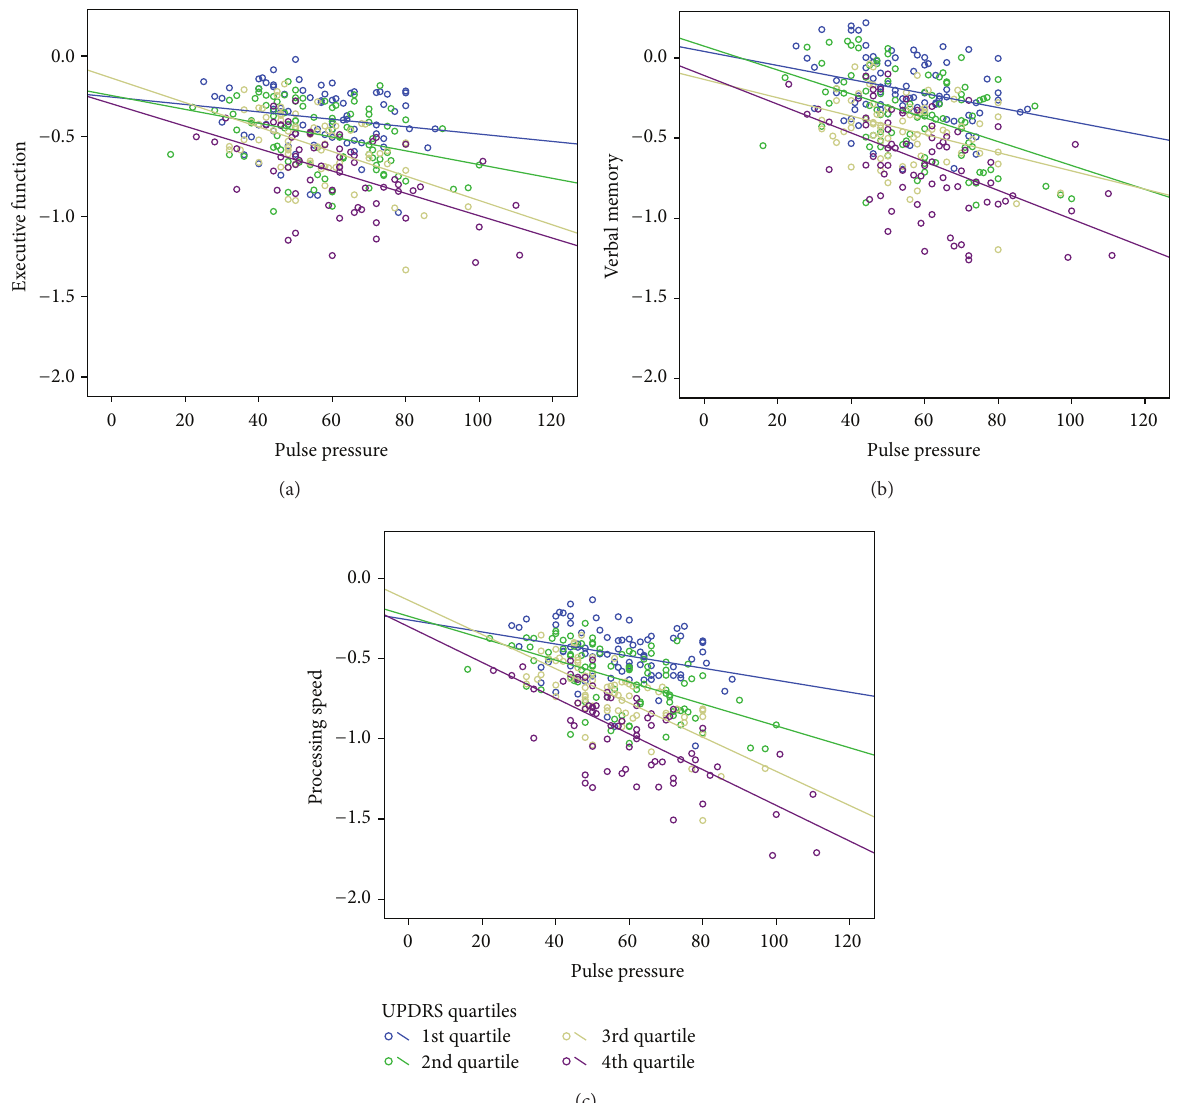
Figure 3: Pulse pressure X UPDRS interaction for 3 cognitive domains. Figure depicts linear relationship between pulse pressure and executive function, delayed verbal memory, and processing speed for each Unified Parkinson’s Disease Rating Scale Part III (UPDRS) quartile (higher quartile means more severe motor